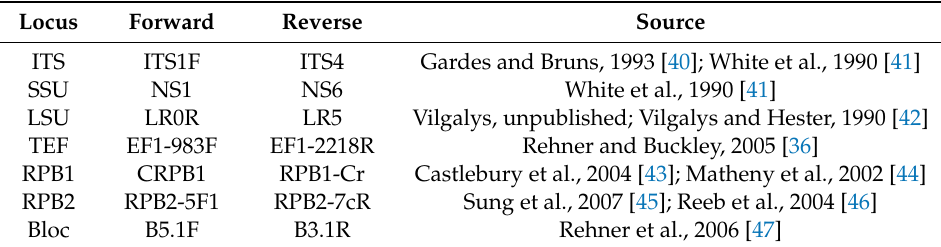
Table 1. Polymerase Chain Reaction (PCR) and sequencing primers used, with